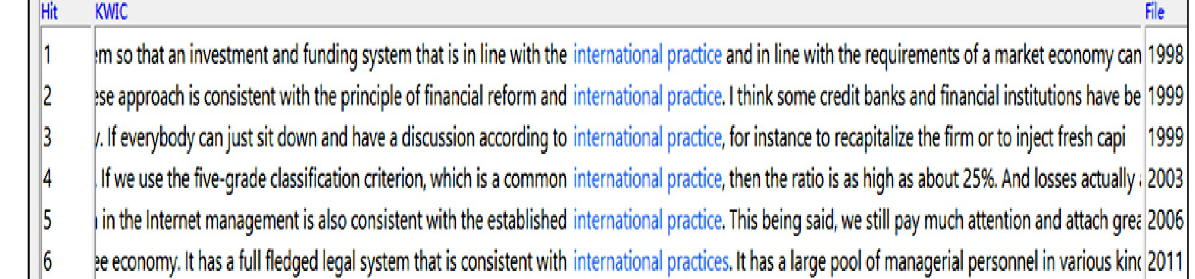
Fig 3. Screenshot of concordance lines featuring ‘international practice(s)’ (by year).